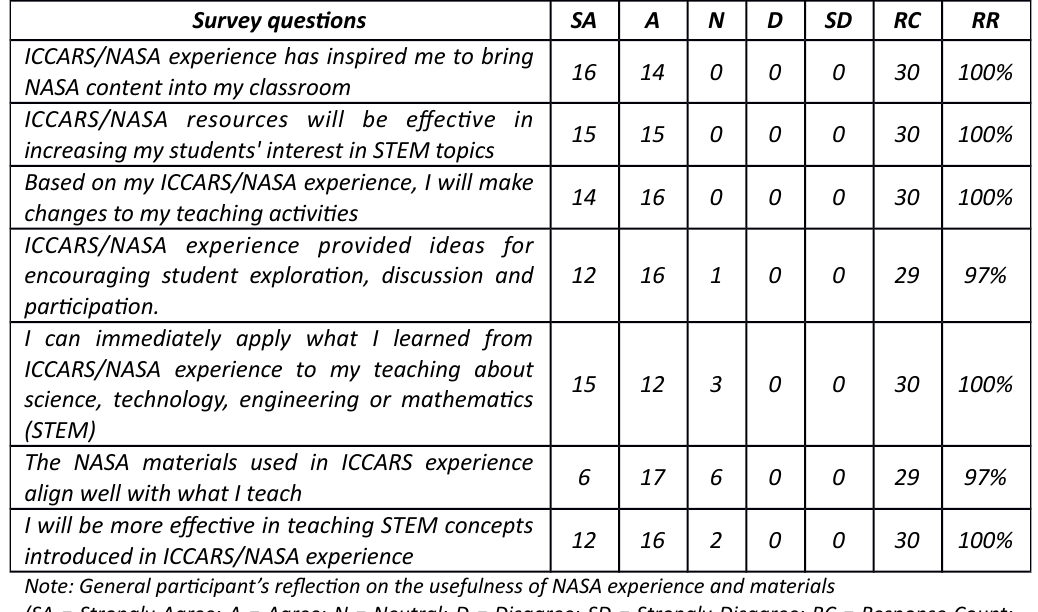
Table 3. Results from partcipants completng survey at the end of the ICCARS project